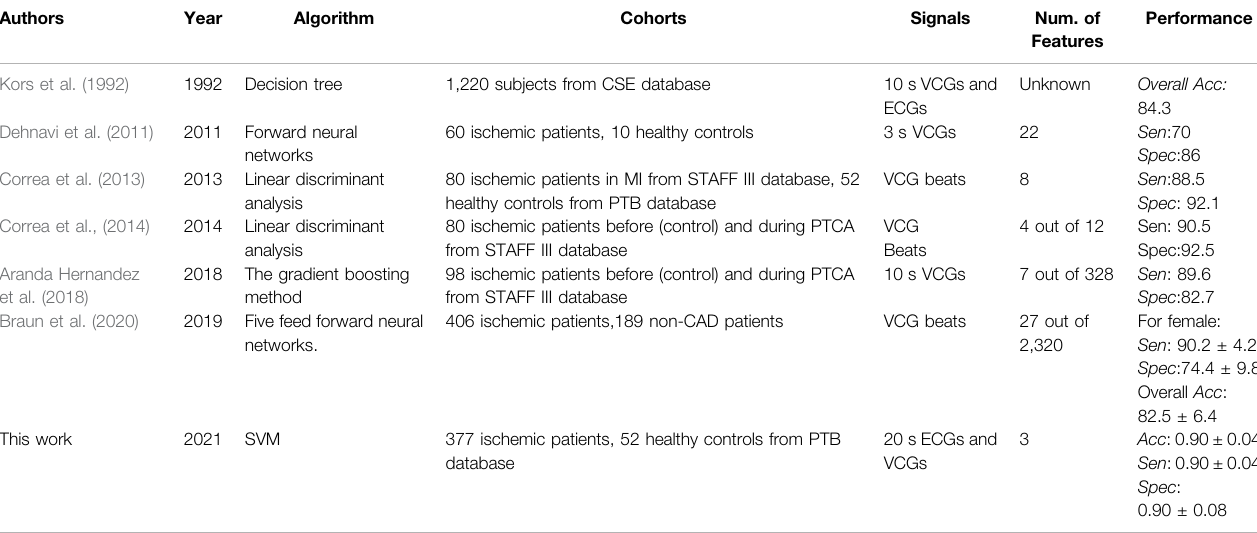
TABLE 8 | Comparison of the proposed model against existing approaches on myocardial ischemia